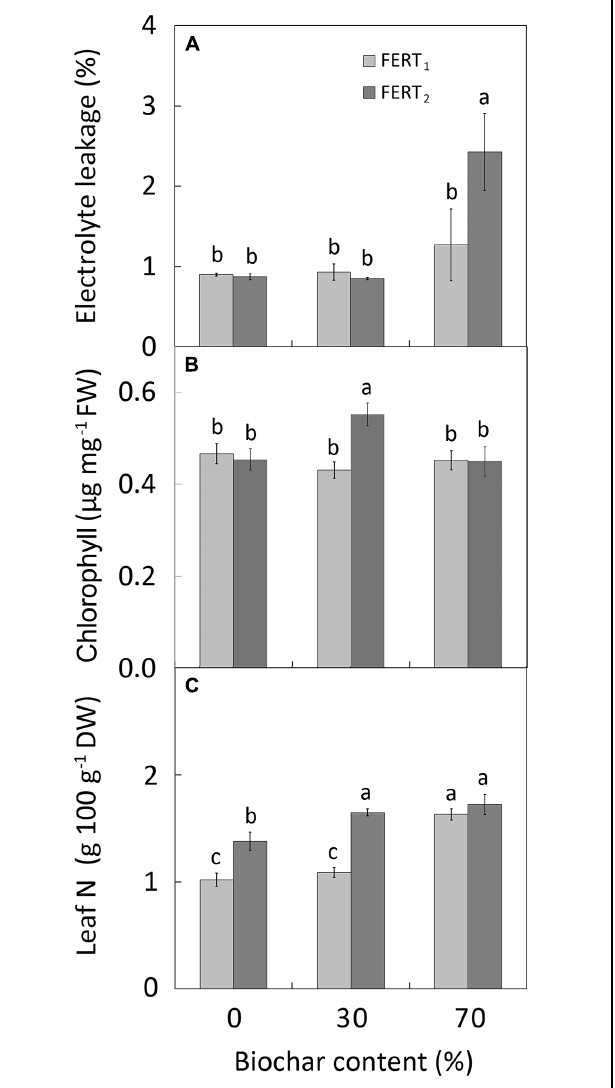
FIGURE 3 | Effect of peat:biochar ratio and fertilization rate on electrolyte leakage (at 28 DAT; A), chlorophyll content (B), and N concentration (C) at the end of the experiment in Pelargonium plants. Bars indicate standard errors ( n = 8). Treatments with different letters are significantly different according to the LSD test ( P = 0.05). In (A) , histogram has been done using the original data, while the used mean separation refers √ x transformation of these to the ANOVA performed on the arcsin